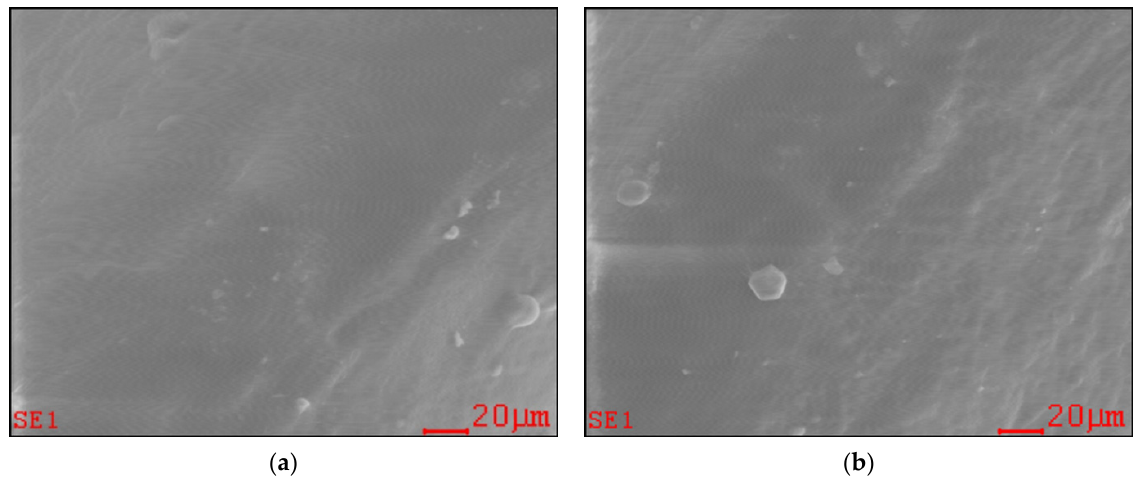
Figure 1. Tooth surface micro-morphology (SEM): ( a ) mouse from the control group; ( b ) mouse from the PAW treated group.